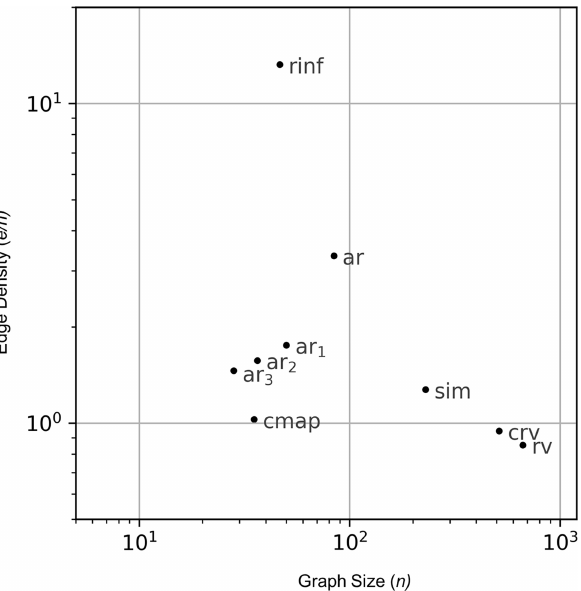
Fig 10. Comparison of readability metricsacrossvisualization methods. Graphsize andedgedensity averagedover 27models(geometric mean)for 9 automatedvisualizations:contactmap(cmap), conventional rulevisualization (rv), compactrulevisualization(crv),SimmuneNetworkViewerdiagram(sim), ruleinfluence diagram(rinf), full modelatom-rulegraph(ar), AR graphwith background removed(ar 1 ), AR graphcompressed with strict edgesignature (ar 2 ) or permissive edgesignature (ar 3 ). The compressionpipeline(ar 1-3 ) is semi- automated, but hereit was appliedautomaticallywith defaultsettings.The fulldatasetis shownin S3Fig.